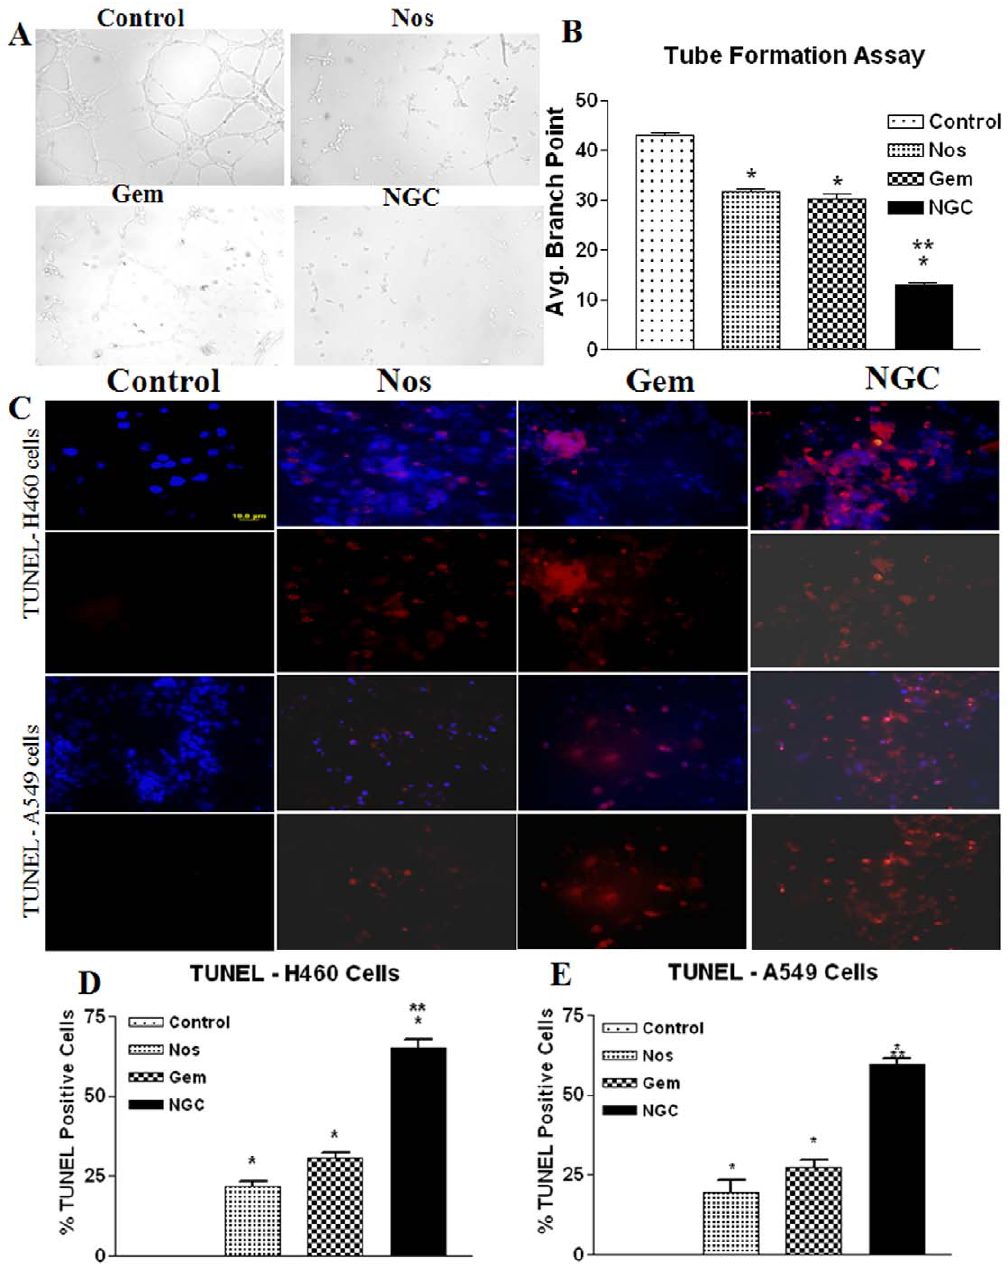
Figure 2. Tube formation assay with HUVEC cells after 6 h (A); quantification of branching points (B); micrographs of cells stained with TUNEL after 72 h (C) and quantitation of apoptotic H460 (D) and A549 cells from TUNEL assay (E). For tube formation assay, HUVEC cells were incubated with Nos (30 m M), Gem (0.4 m g/ml) and NGC on polymerized Matrigel at 37 u C. After 6 h, tube formation by endothelial cells was photographed and the capillary tube branch point formation were quantified (n=3). For TUNEL assay, H460 cells were treated with Gem 0.4 m g/ml, Nos 30 m M, and, NGC and A549 cells were treated with Gem 0.3 m g/ml, Nos 50 m M, and, NGC. Control cells were untreated. Micron bar =10 m m. Cells were quantitated by counting 100 cells from 6 random microscopic fields. Data are expressed as mean + SD